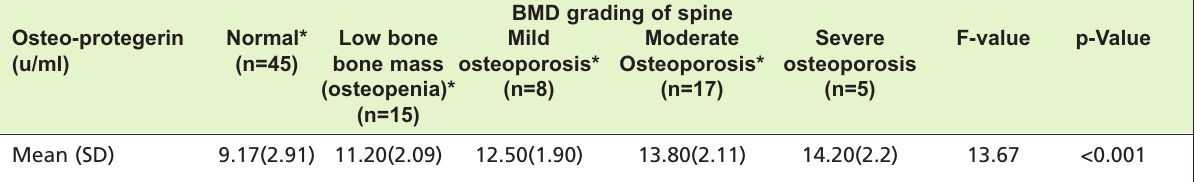
Shows the distribution of osteoprotegerin (u/ml) level between BMD grading Table II: